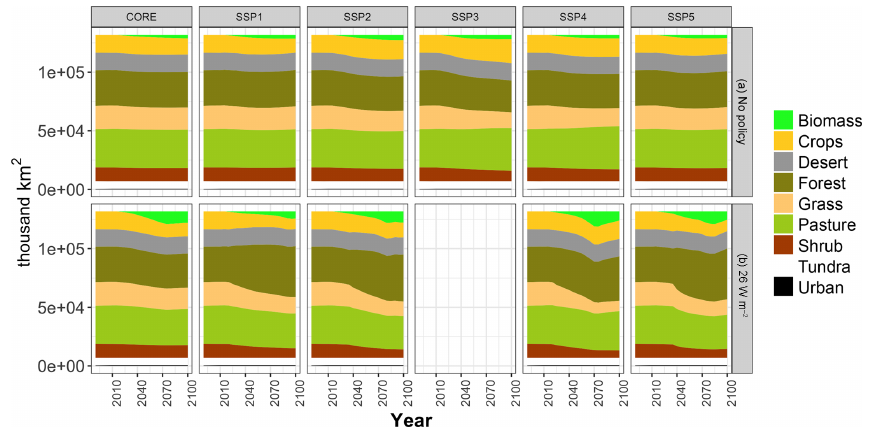
Figure 14. Global land cover by type for all scenarios. Without climate policy (a) , and the 2.6Wm − 2 scenarios (b) . Columns indicate the underlying socioeconomic assumptions.